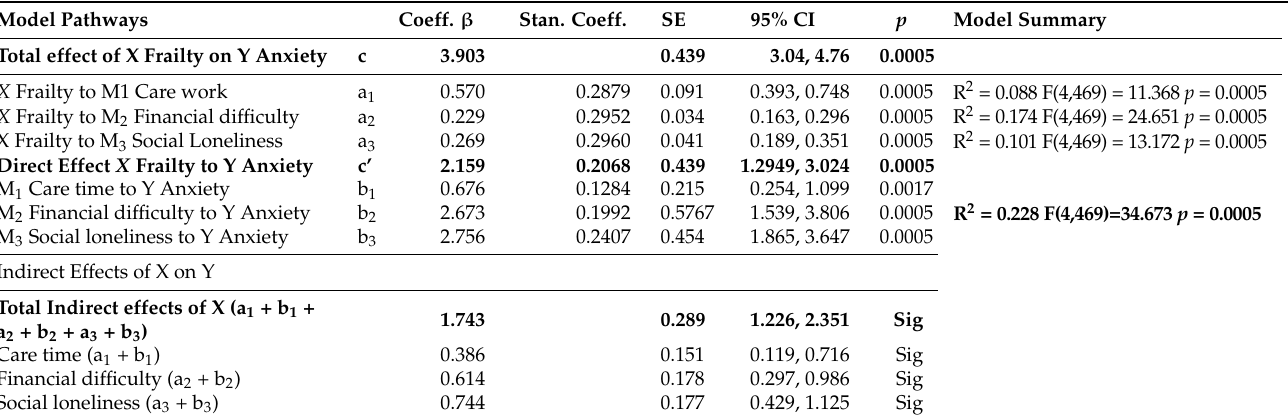
Table 3. Testing weekly care work, financial difficulty, and social loneliness as mediators in the relationship between caregiver frailty and anxiety.